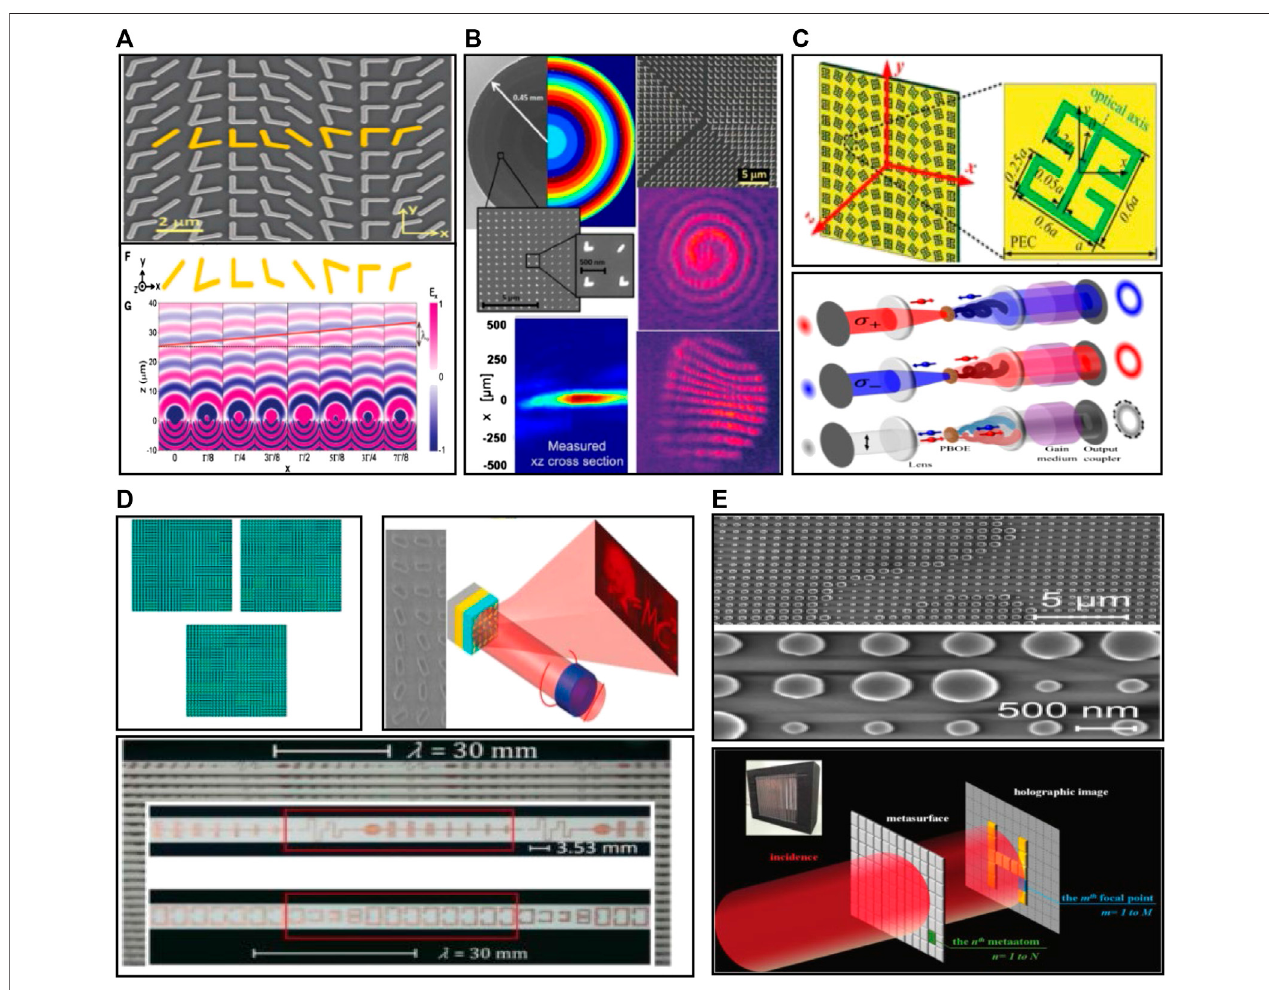
FIGURE 2 | Phase-modulated metasurface design and its typical applications. (A) Basic metasurface [70], (B) metasurface with focusing and vortex electromagnetic wave generation [36, 70, 71], and (C) , (D) , (E) several examples of high ef fi ciency metasurface design [73, 74, 77 – 79, 81, 82].